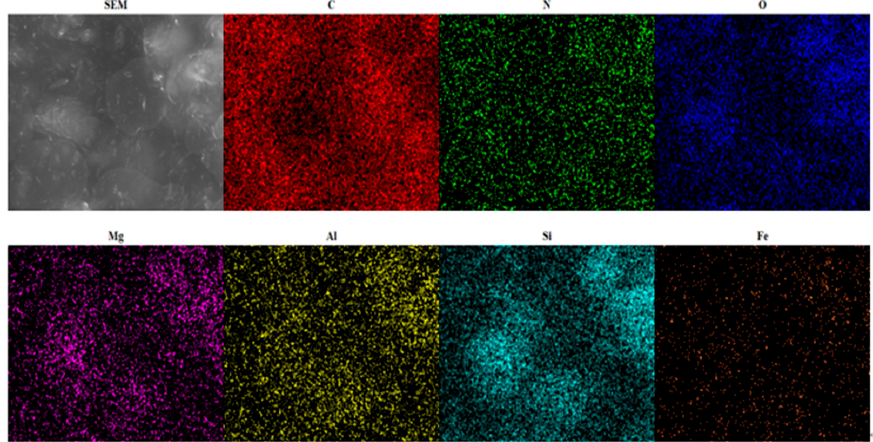
Figure 6. Elements of the surface of distribution of PI-50% ATP composite membrane.